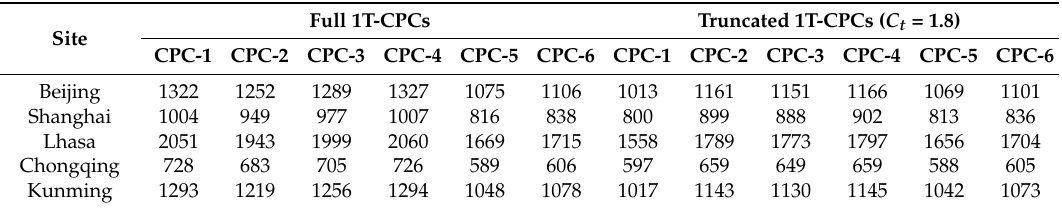
Table 5. Annual radiation on EST of 1T-CPCs with θ a = 26 ◦ and ρ = 0.92 (MJ/m). Full Site